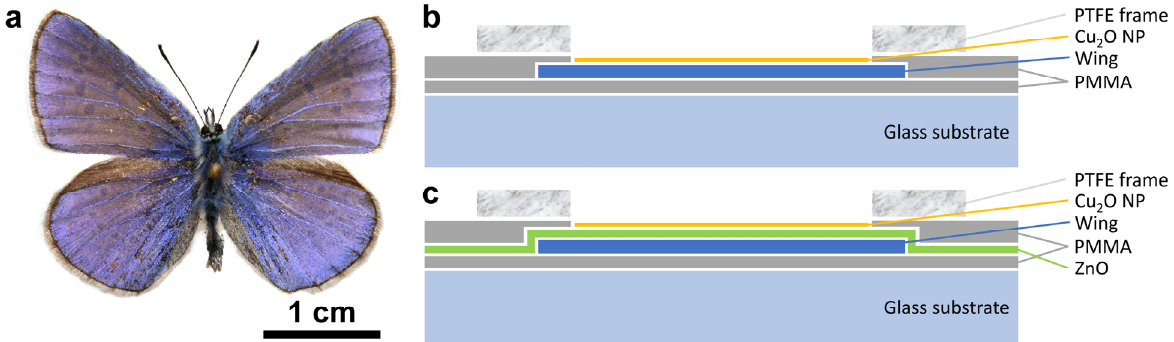
Figure 1. Male Polyommatus icarus butterfly and typical sample structures used. ( a ) Dorsal wing surfaces of a male P. icarus specimen. Note the homogeneous blue coloration over the entire surface of the four wings; ( b ) Type-1 sample structure without 15 nm ZnO layer on the butterfly wing before the Cu 2 O deposition; ( c ) Type-2 sample structure with 15 nm ZnO layer deposited by ALD on the butterfly wing before the Cu 2 O deposition. Note that the various layer thicknesses are not drawn to scale.